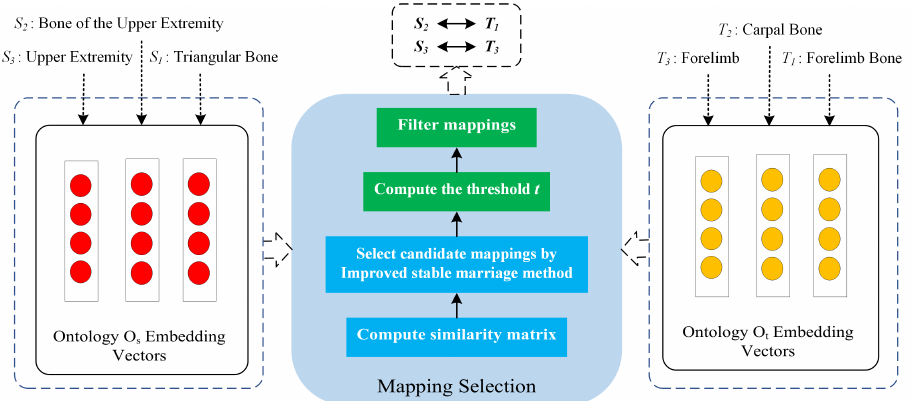
Figure 4. Overall proposed ontology matching architecture.